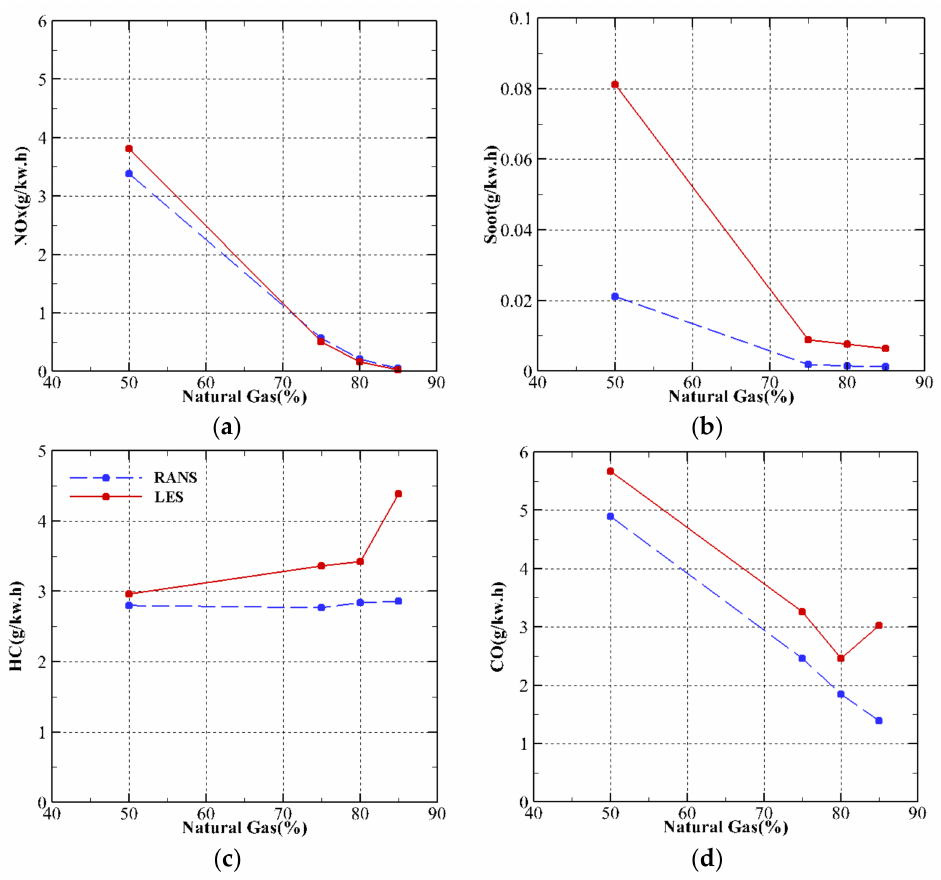
Figure 7. Comparison of LES and RANS model for: ( a ) NO x , ( b ) soot, ( c ) HC and ( d ) CO emissions with different natural gas